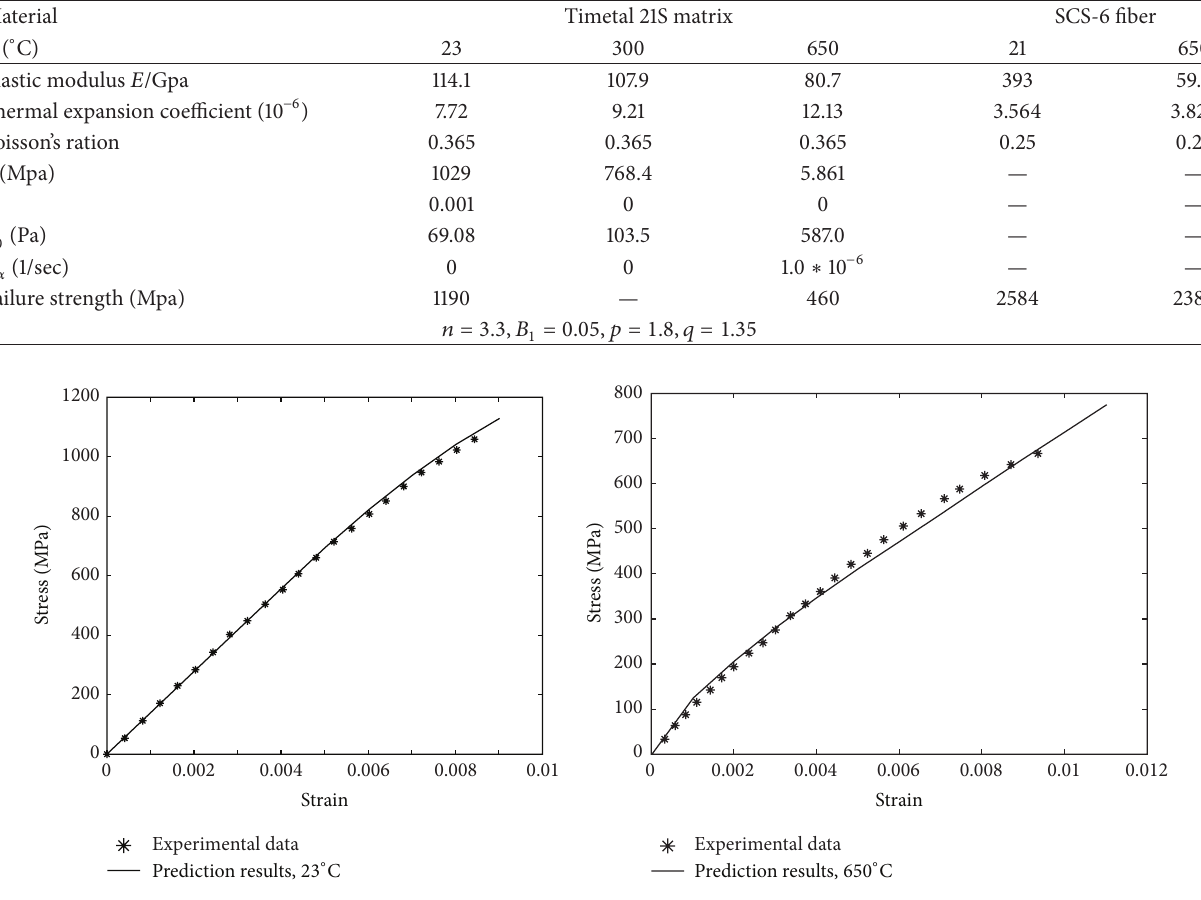
laminate: (a) 23 ∘ C and (b) 650 ∘ s